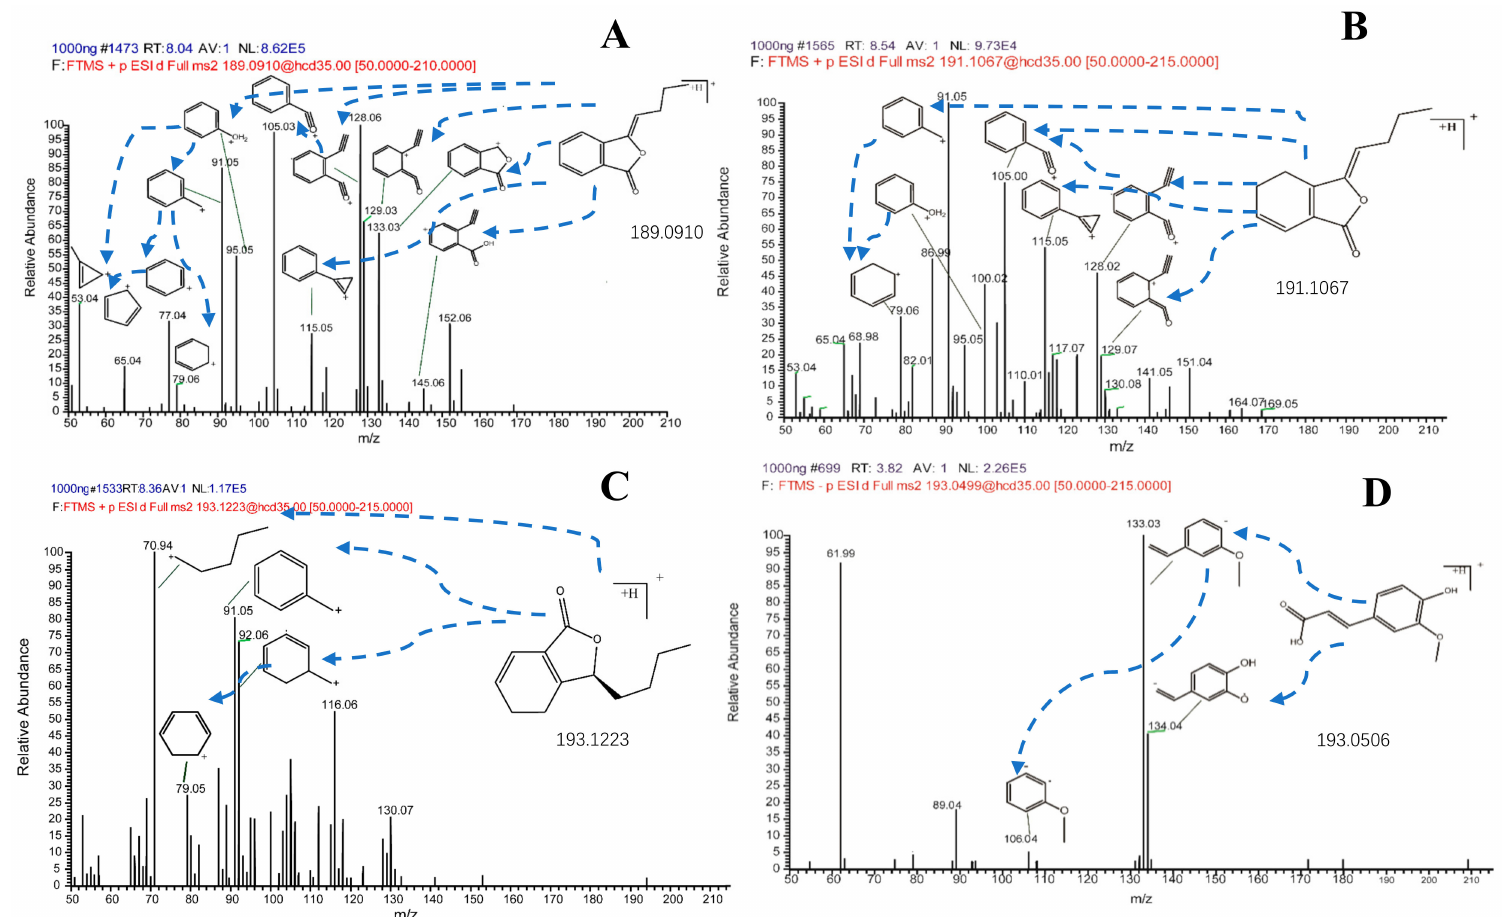
Figure 2. The fragment mass spectrometry (MS / MS spectrometry) of butylidenephthalide ( A ), ligustilide ( B ), senkyunolide A ( C ) and ferulic acid ( D